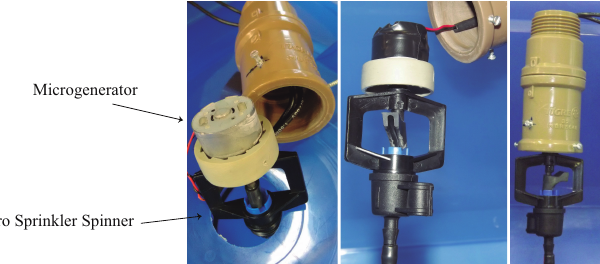
Figure 6. Photograph of the DC microgenerator adapted on the top of a conventional micro sprinkler